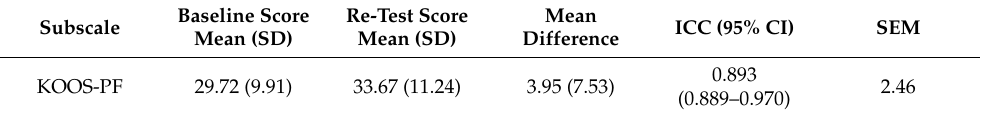
Table 2. Test and retest reliability and measurement error of